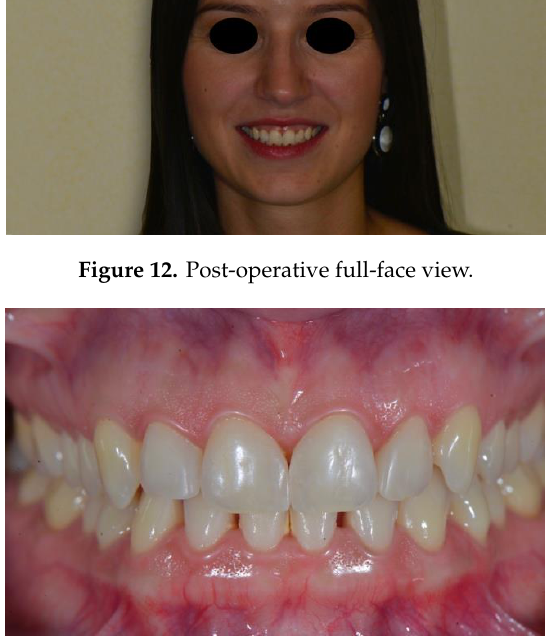
Figure 12. Post-operative full-face view.